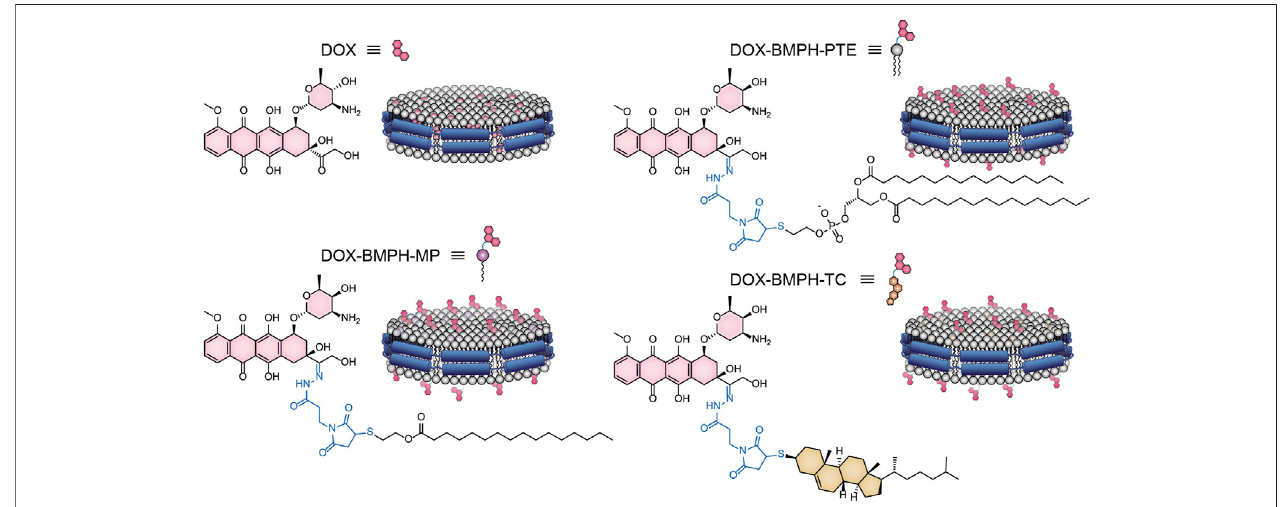
FIGURE 1 | A fl ow chart summarizes the individual steps for the MD simulation of ND